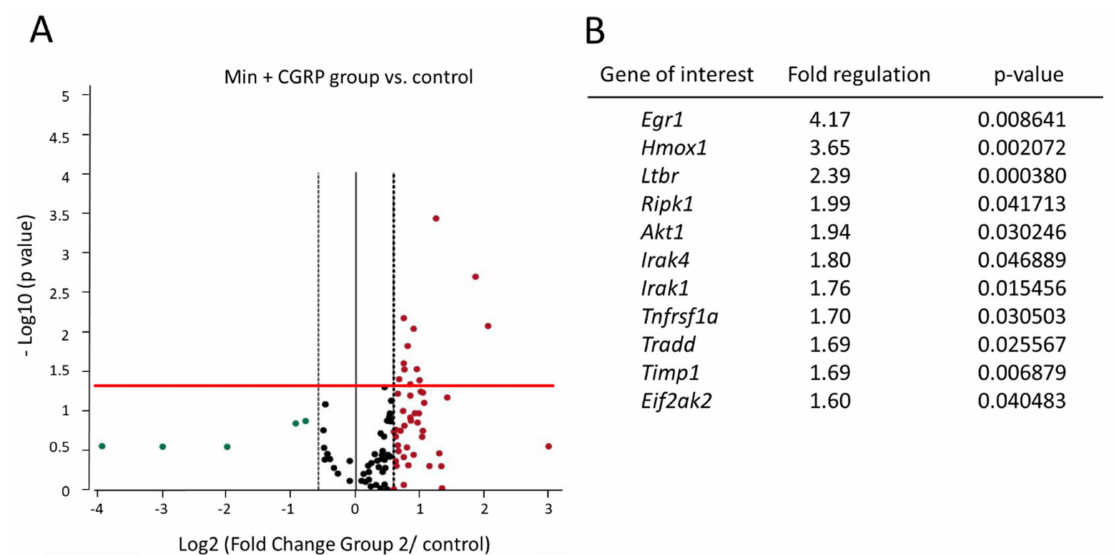
Figure 2. Fold regulation of various genes of NF- κ B signaling pathway in the glial cells of TG after 30 min treatment with Minocycline followed by overnight stimulation with 1 µ M CGRP (Min + CGRP) compared to no treatment control group. ( A ) Volcano plot showing RT-PCR array data to compare the normalized expression of all the genes included in the array between the Min + CGRP group and control group (no treatment group). The red dots are the genes which were upregulated, and green dots were the genes which were down regulated. The red line shows where p = 0.05 with points above the line having p < 0.05 and points below the line having p > 0.05. Dots above the red line indicate genes-of-interest that display both more than 1.5 fold-changes ( x axis) and p < 0.05, statistical significance ( − log10 of p value, y axis). Those points having a fold-change less than 1.5 are shown in black dots. ( B ) Genes-of-interest, which were significantly upregulated in Min + CGRP group compared to the no treatment control group. Fold Regulation cut o ff : 1.5; p -Value cut o ff : 0.05, n =